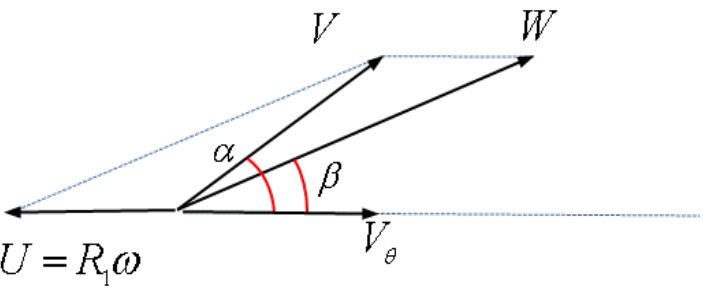
Figure A2. Velocity triangle at the outlet boundary of the